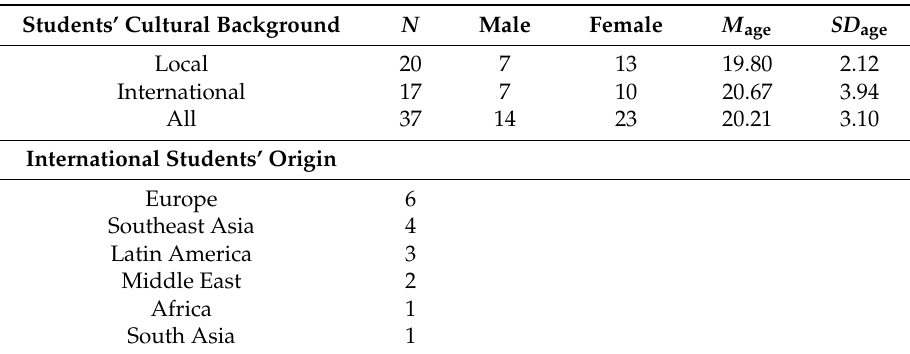
Table 1. The descriptive presentation of the